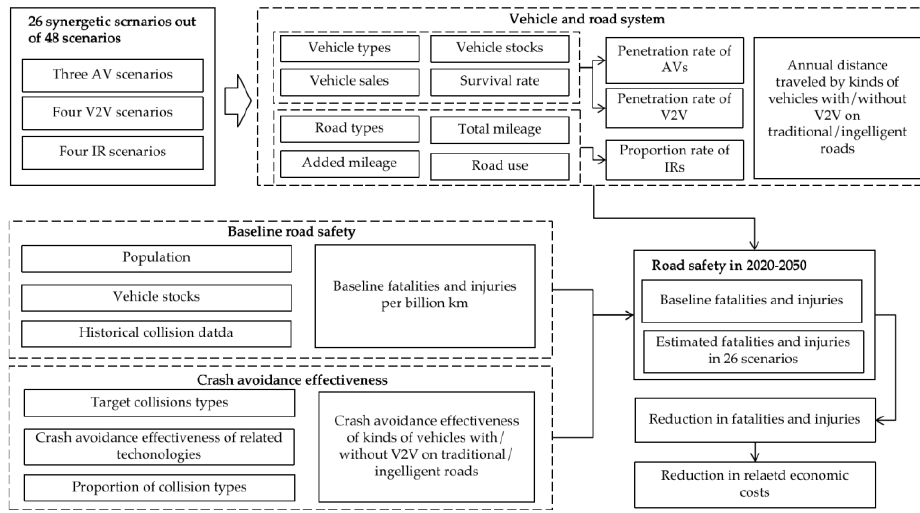
Figure 1. The analytical framework used in this study.